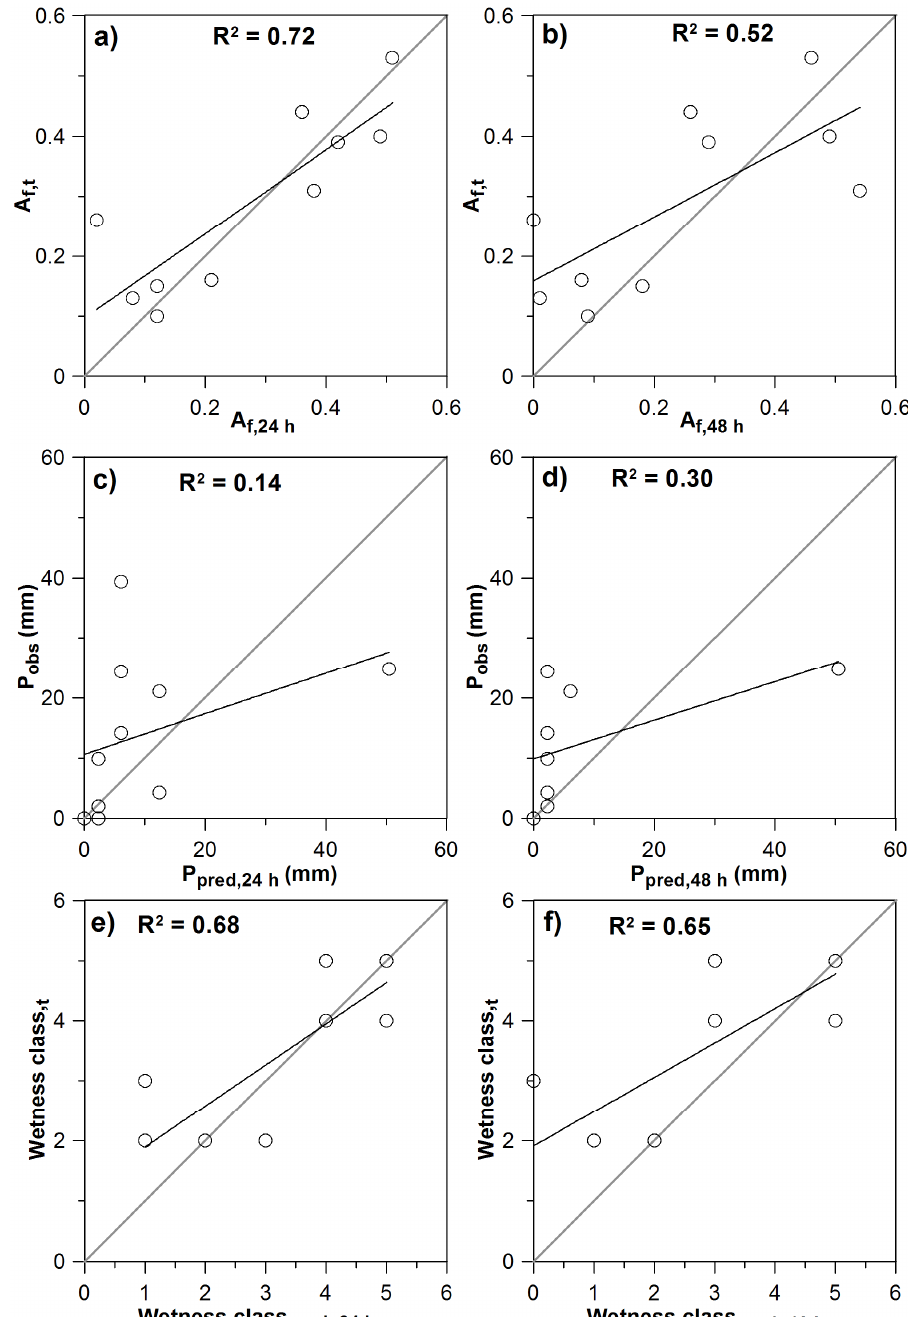
Figure 9. Comparison of modeled fractional saturated areas ( a , b ), predicted vs. observed precipitation ( c , d ), and modeled wetness classes ( e , f ) for the 10 largest storm events observed in Salmon Creek watershed between July 2006 and December 2009. Plots ( a ) and , -values computed with the VSA water balance model based on observed ( b ) compare A f t , and A values modeled using 24 h and 48 h GFS MOS weather data versus A f ,24 h f ,48 h , P and P are the observed projected meteorological data for each event. P obs pred ,24 h pred ,48 h and 24 h, 48 h forecasted total daily precipitation amounts for these events. Plots ( e ) and ( f ) compare the wetness class predicted with the VSA water balance model using observed ) and 24 h (wetness class, ) and 48 h (wetness class, ) forecasted (wetness class, t 24 h 48 h meteorological